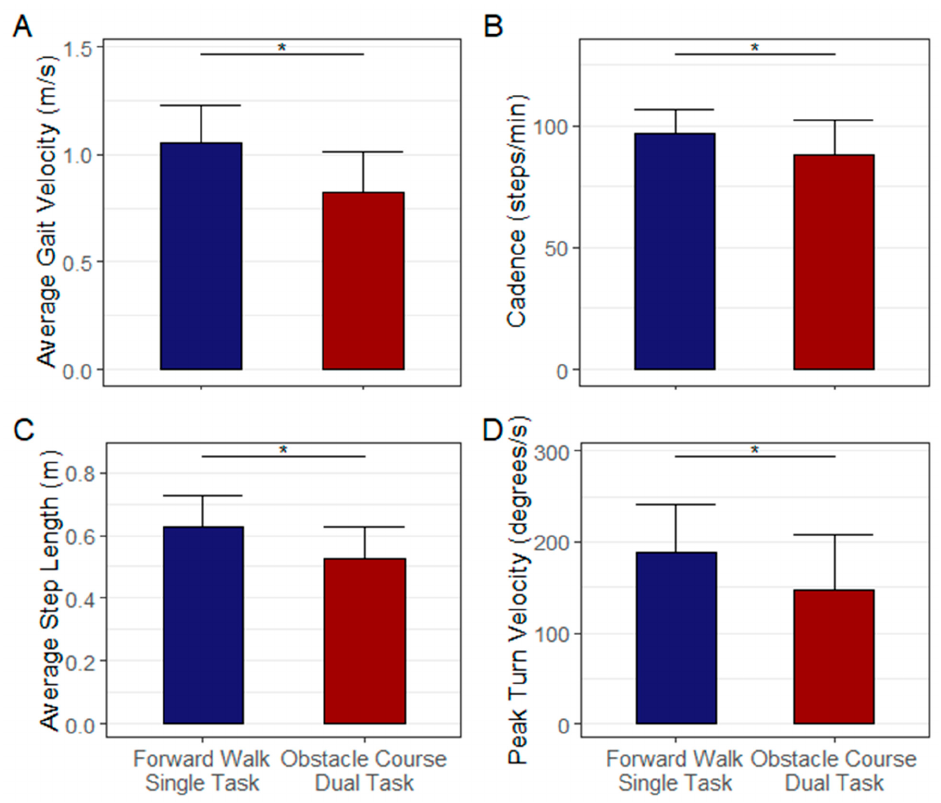
Figure 4. Summary gait and turning metrics derived from the HoloLens2 data for continuous forward walking (blue) and walking through the digital obstacle course under dual-task conditions (red). Gait measures while performing the dual-task obstacle condition resulted in significantly slower average gait velocity (Panel A ), decreased cadence (Panel B ), shorter average step length (Panel C ), and lower peak turning velocity (Panel D ). These data indicate that the DART protocol is an effective method of eliciting dual-task interference in Parkinson’s disease. The * denotes a significant difference from single-task to dual-task performance ( p <